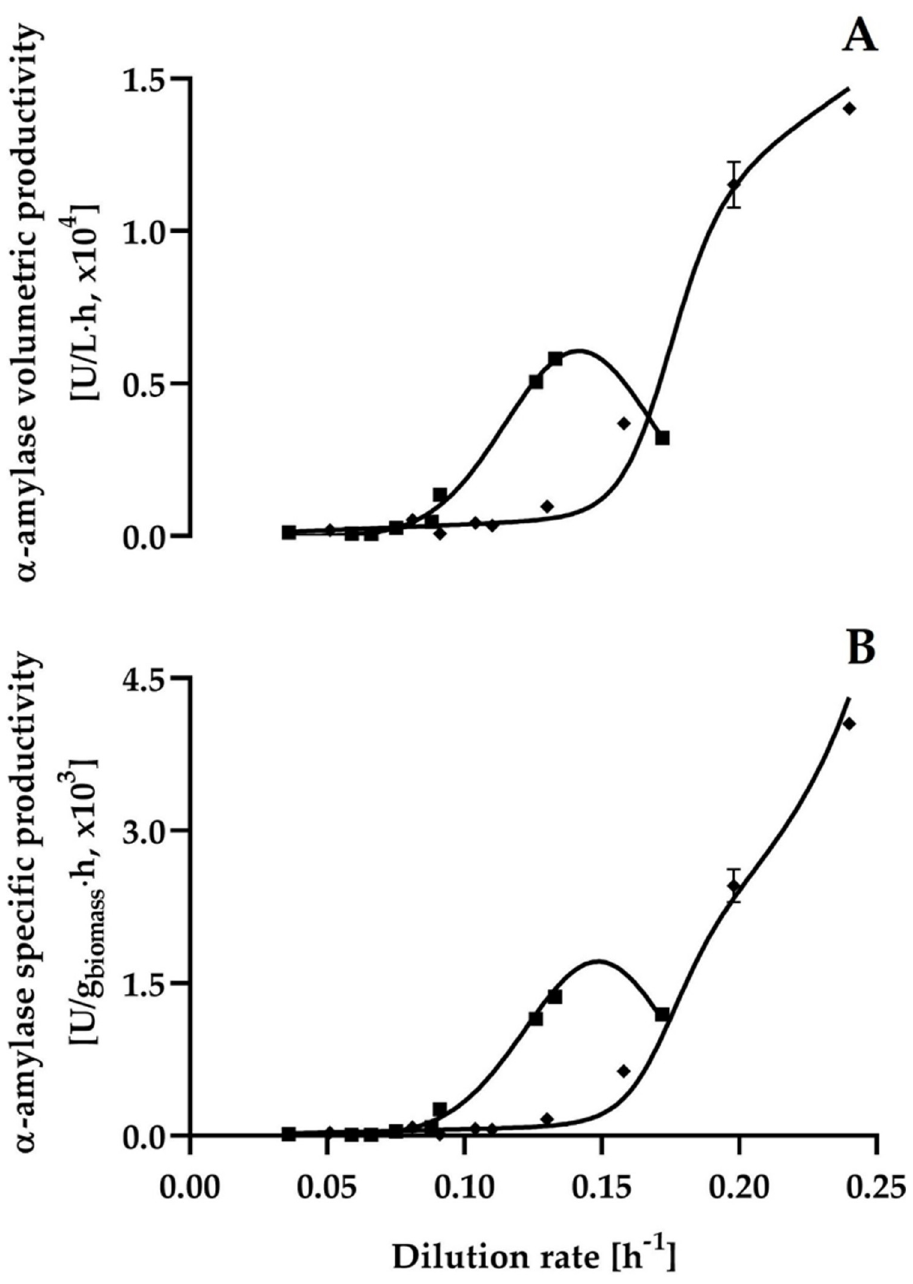
Fig 5. Steady-state α -amylase volumetric (A) and specific (B) productivities versus dilution rate for C . wangnamkhiaoensis continuous cultures. ◼ , maltose; ◆ ,